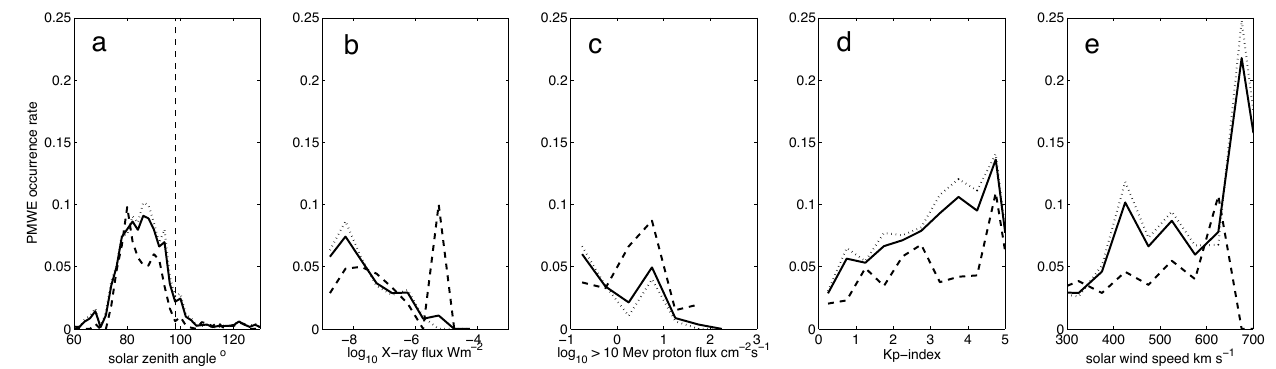
Figure 4. PMWE occurrence rates for the months March–October, at any height below 75km, as a function of (a) solar zenith angle, (b) solar X-ray flux, (c) solar proton flux, (d) Kp index and (e) solar wind speed. For (b–e) , only observations for solar zenith angle less than 98 ◦ are considered. The dashed line is for the year 2012, the dotted line for 2013 and the solid line for both together. Occurrence rates are calculated as the number of times during which PWME were observed divided by the number of observations which were made (one observation each